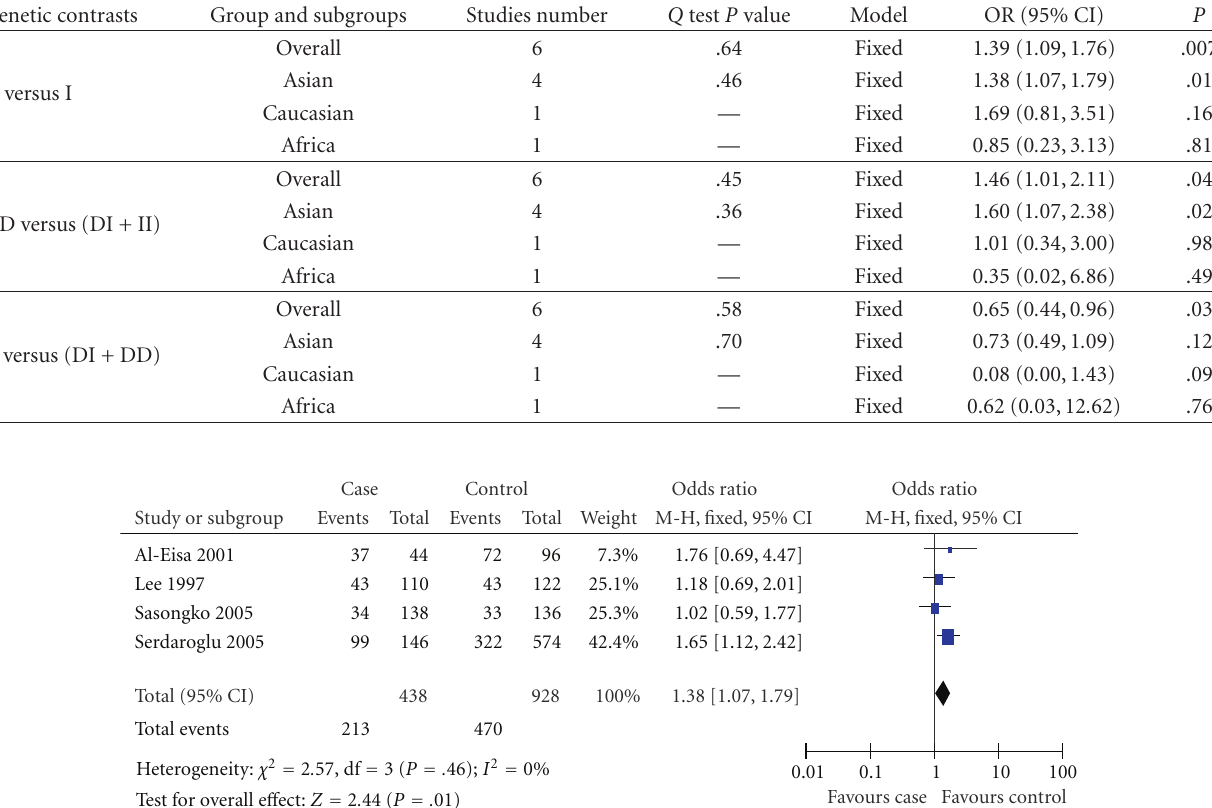
Table 2: Meta analysis of the association of ACE I/D gene polymorphism with MCNS risk.